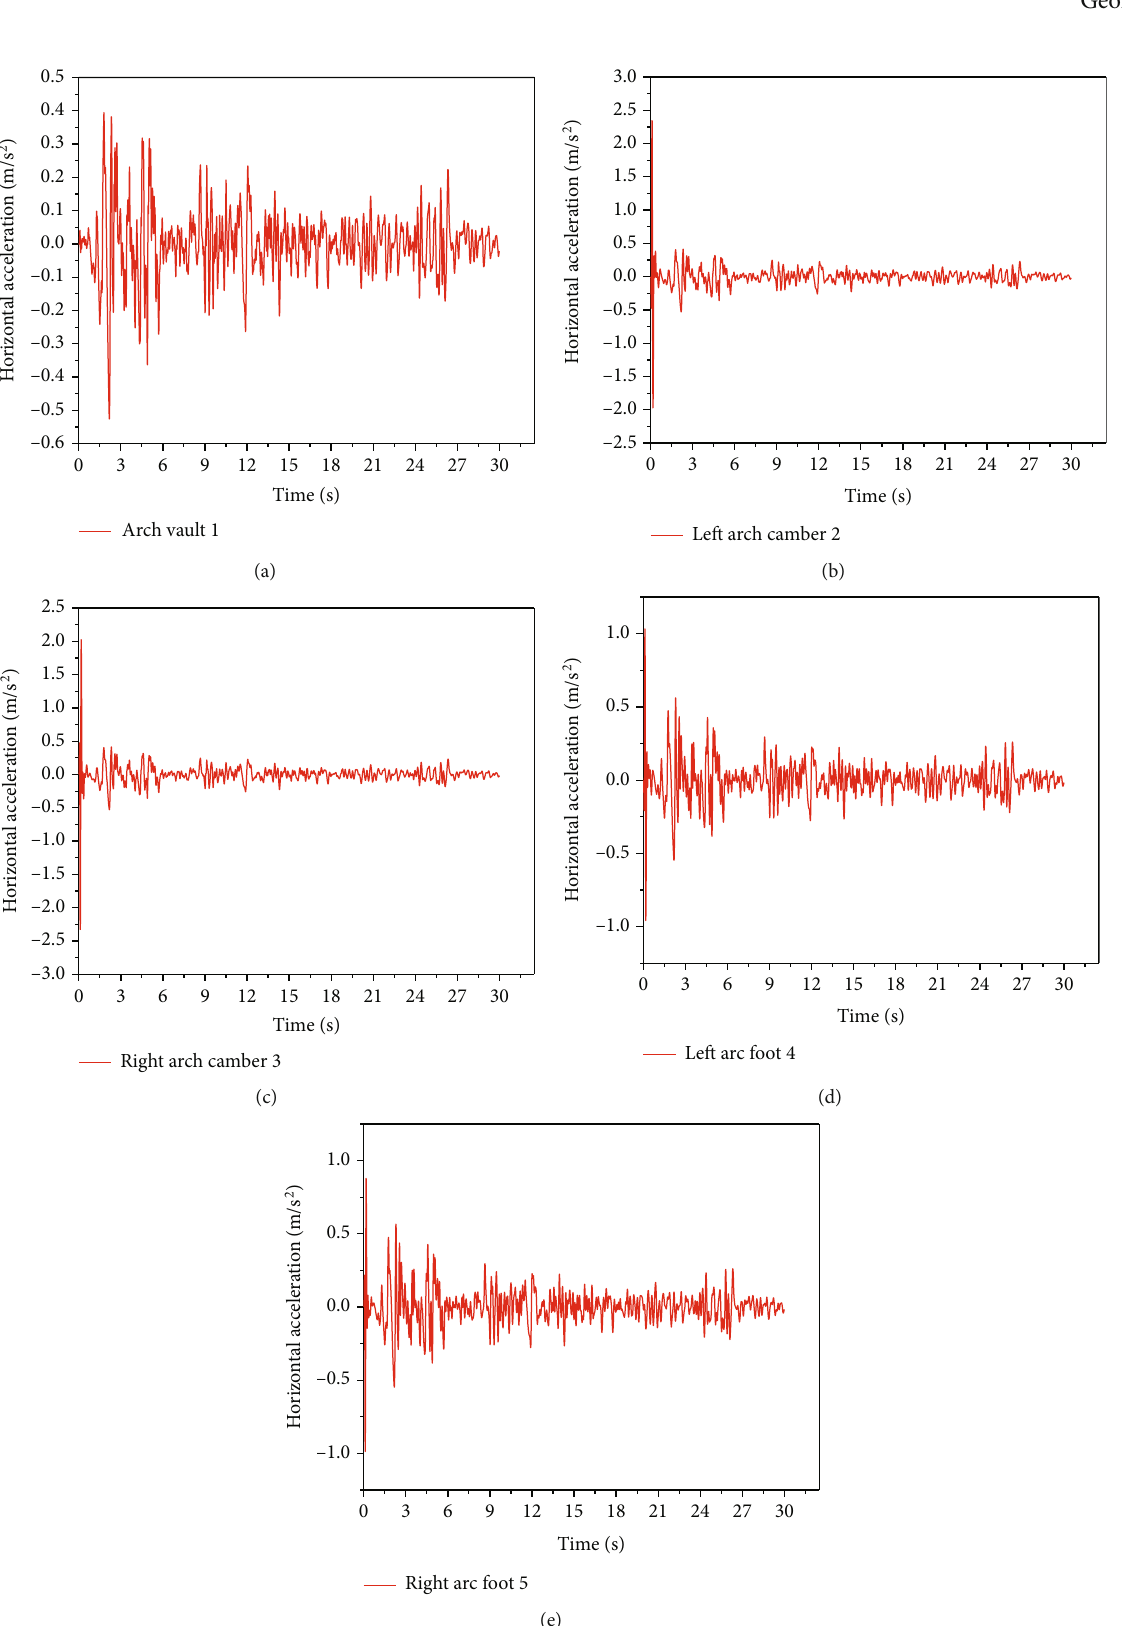
Figure 8: Horizontal acceleration time-history diagram of the fi ve key points under 0.05g seismic